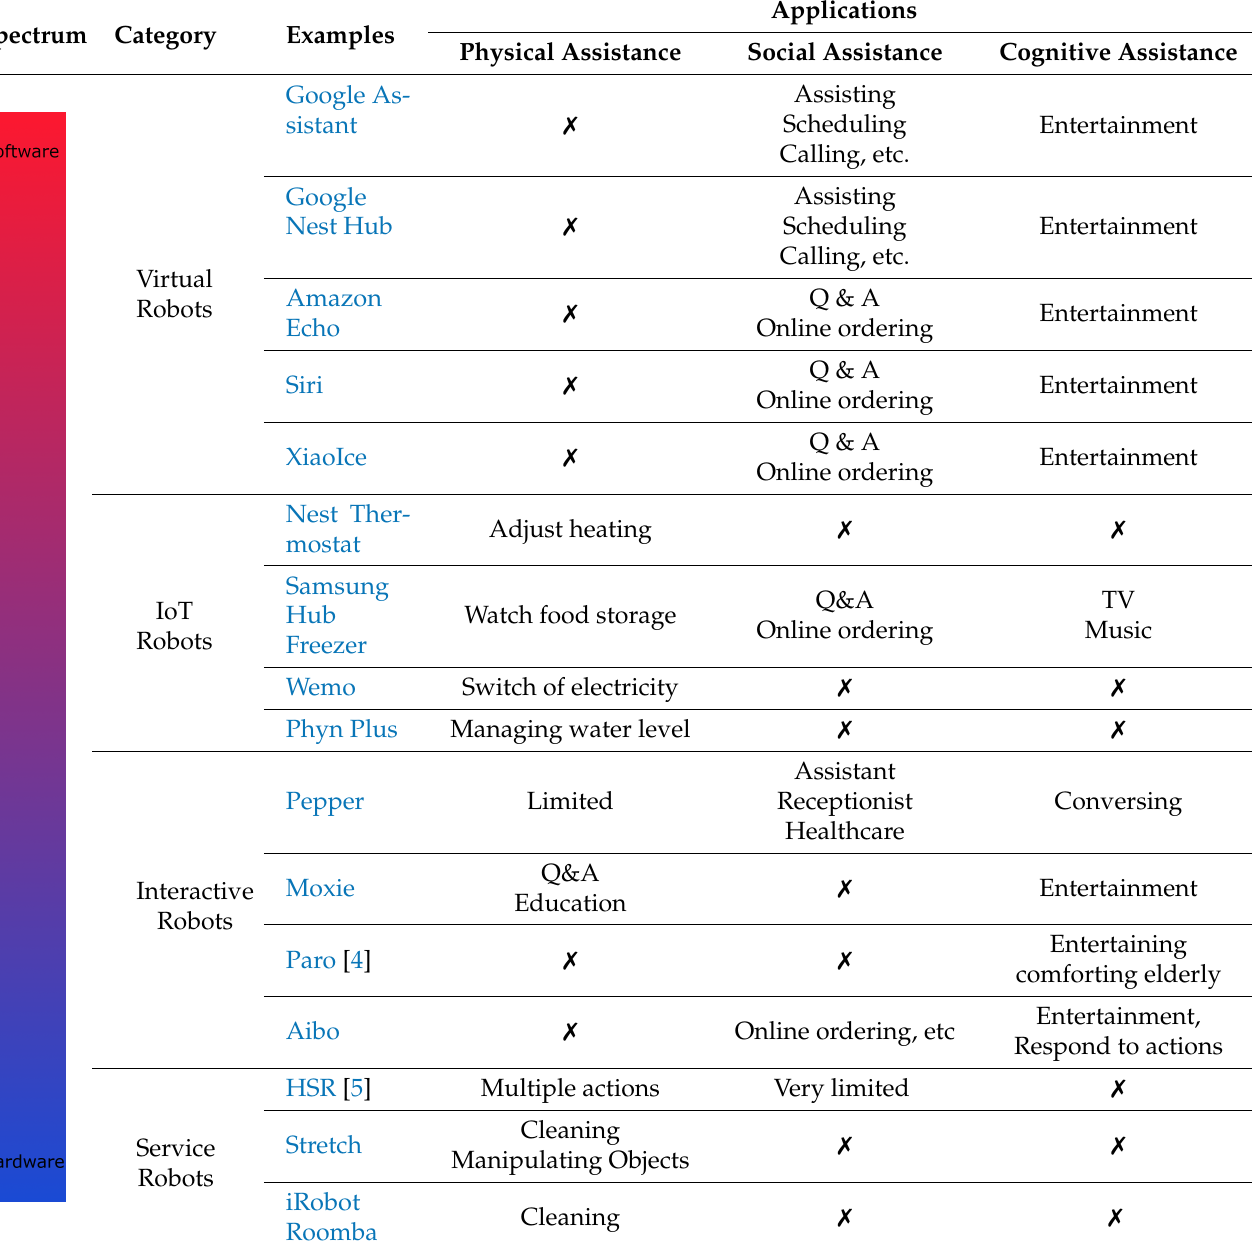
Table 1. The taxonomy and the software–hardware spectrum of domestic